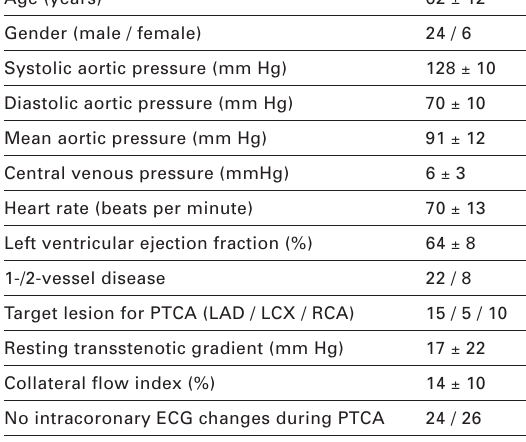
Patient characteris- tics.